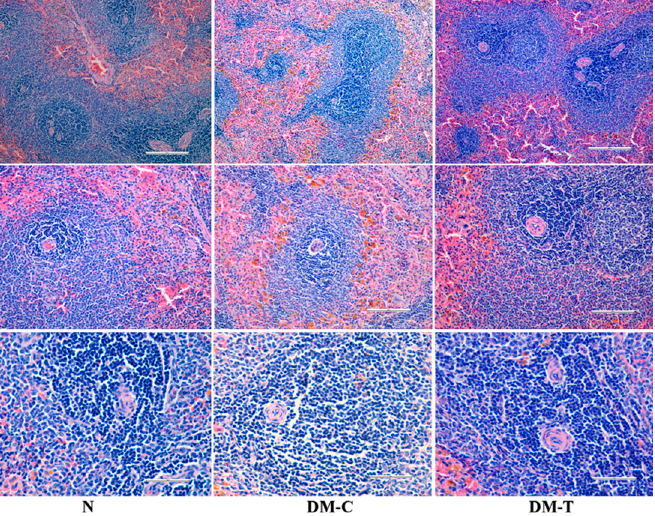
Figure 6. Histopathologic examination of spleen in N, DM ‐ C, and DM ‐ T rats. In accordance with the observations on the measured organs’ weights, the pre ‐ sent ‐ noticed positive reaction of the spleen of treated diabetic rats may be an indication of non ‐ toxicity for rats in acute administration of flaxseed extract.